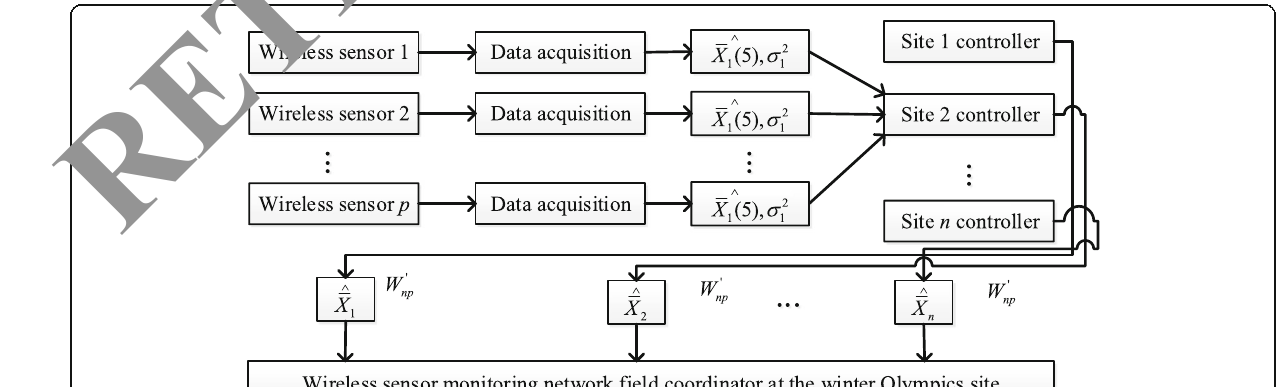
Fig. 3 The adaptive weighted data fusion application